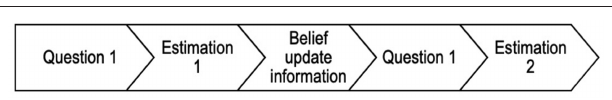
FIGURE 5 | Schematic representation of the belief updating test.